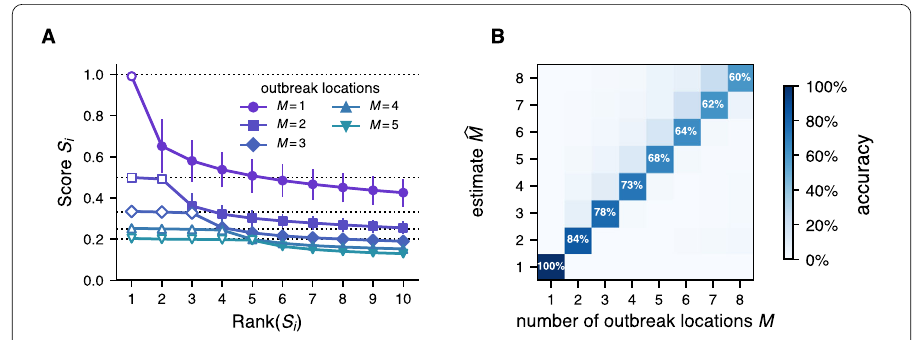
Figure 4 Estimation of the number of outbreak origins from the score distribution. A The scores S i of the 10 highest-scoring locations, for a varying number of outbreak origins M . We find that the top M locations corresponding to the true outbreak origins have a distinctly high score (hollow symbols), at around the expected values of E ( S i ) = 1/ M (dotted lines). The scores of further locations follow an exponentially decaying distribution. Error bars indicate the standard deviation. B Based on the characteristic form of the score distribution, we define an estimation heuristic for the number of outbreak locations, P ( (cid:5) M = M ) (see main text). The heuristic correctly identifies the true number of outbreak sources M , where the accuracy decreases with rising number of outbreak origins and tends to overestimate the number of outbreak